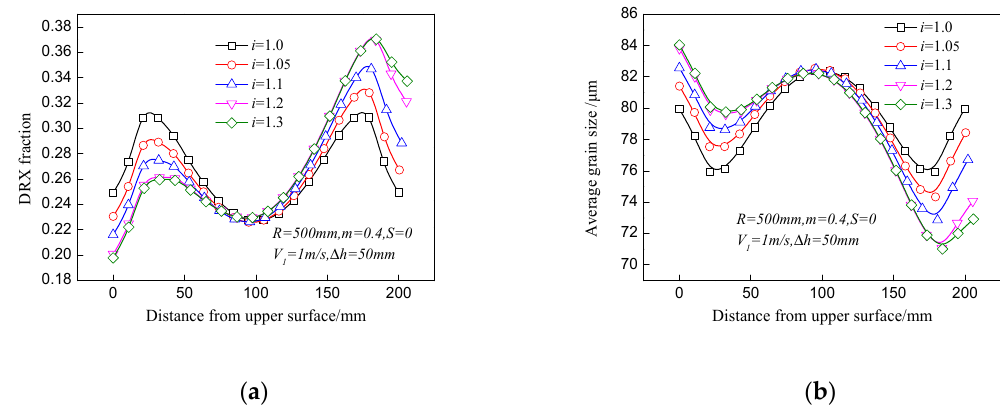
Figure 5. Effect of speed ratio on distributions of ( a ) DRX fraction and ( b ) average grain size in asymmetrical shear rolling.